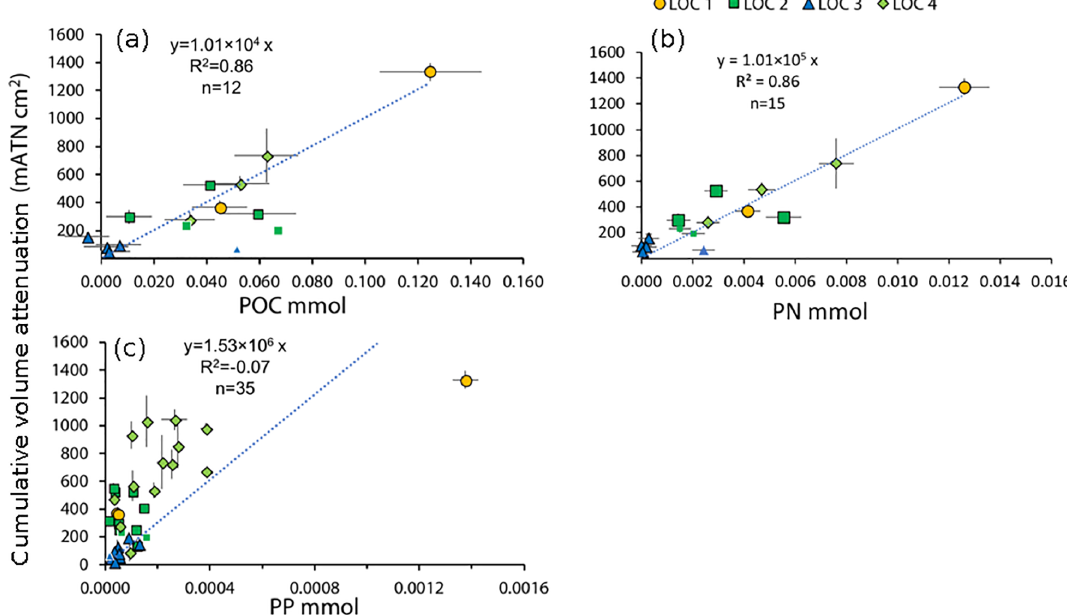
Figure 5. Data and regressions of sample POC (a) , PN (b) and PP (c) vs. cumulative volume attenuance. Fits are forced through zero. Smaller symbols in all plots denote samples excluded from the POC regression analysis; these had C / N values >20 and were likely contaminated for carbon and not nitrogen. No data were excluded from PN or PP